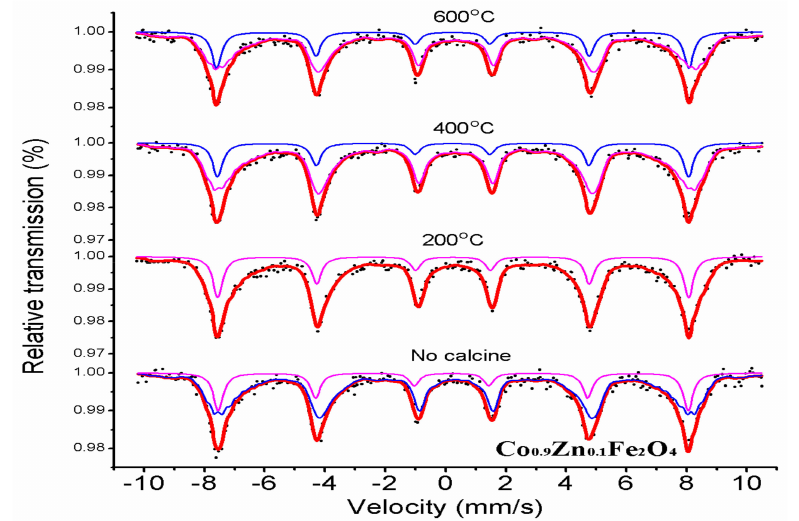
Figure 7. The Mössbauer spectrum of Co 0.9 Zn 0.1 Fe 2 O 4 calcined at different